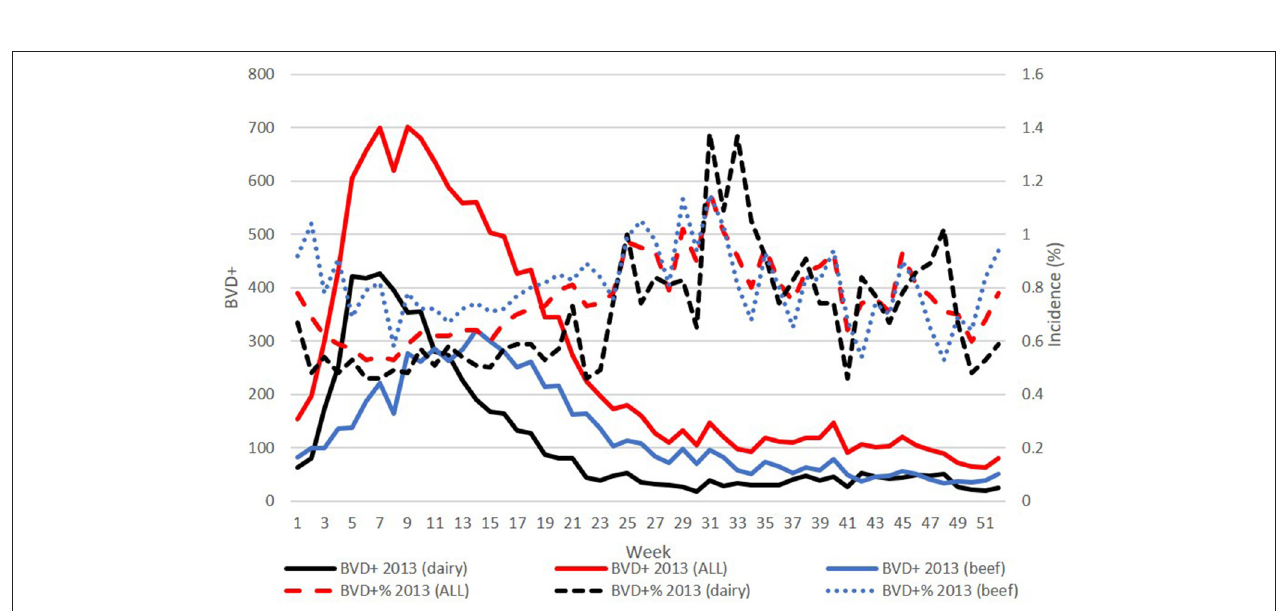
FIGURE 3 | Plots of weekly number (left y-axis) overall, and from dairy and beef herds in 2013 (solid lines), and the corresponding weekly incidence of BVD + births (right y-axis) detected each week (broken lines). BVD + calves are those with an initial positive or inconclusive result without a negative retest result.